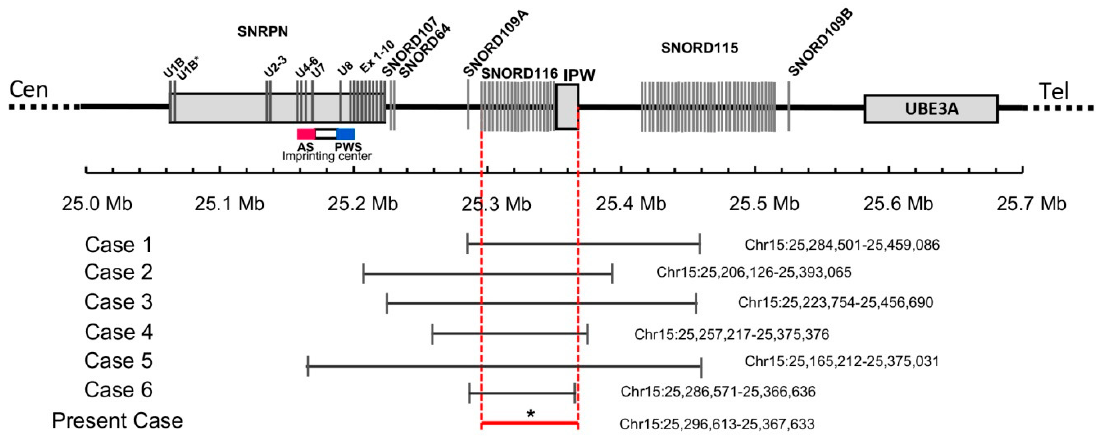
Figure 1. Schematic map of the 15q11.2 region between the SNRPN and UBE3A genes, which is represented at scale with physical distance in Mb. The reported deletions are shown at the bottom drawn to scale and depicting genomic coordinates for build hg19. * The exact breakpoints of the deletion in the present case are not available. The minimal critical region spans from 25296613bp to 25367633pb as shown by the red horizontal line.